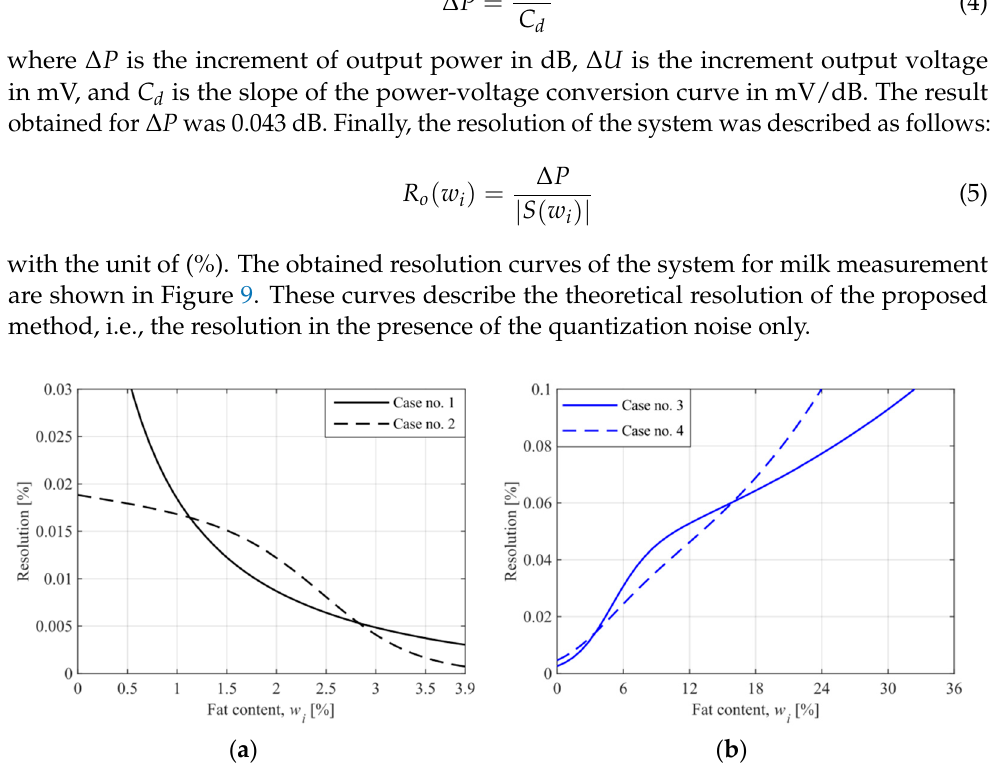
Figure 9. The resolution curves of the proposed system for milk samples (( a )—cases no. 1 and 2, for the operating point at 3.9%, ( b )—cases no. 3 and 4, for the operating point at